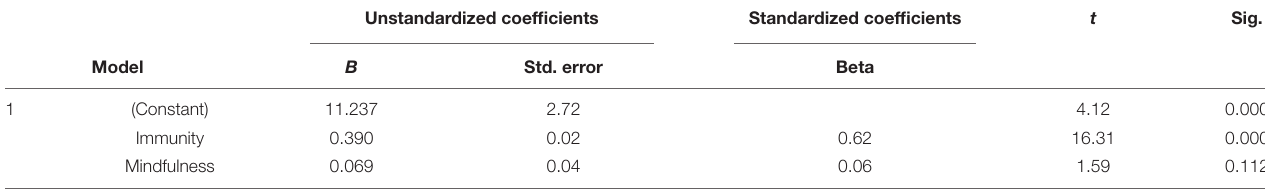
TABLE 7 | Coefficients for teachers’ immunity, mindfulness, and